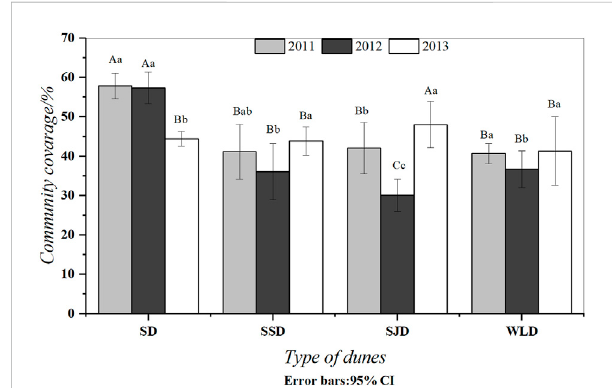
FIGURE 1 Coverage dynamics of different dunes. Note: Differing capital letters indicate that coverage in different communities was signi fi cantly different ( p < 0.05), while differing lower-case letters indicate that the coverage of the same communities in different yearswassigni fi cantlydifferent( p < 0.05).Thesameletterindicatesno signi fi cant difference ( p > 0.05).